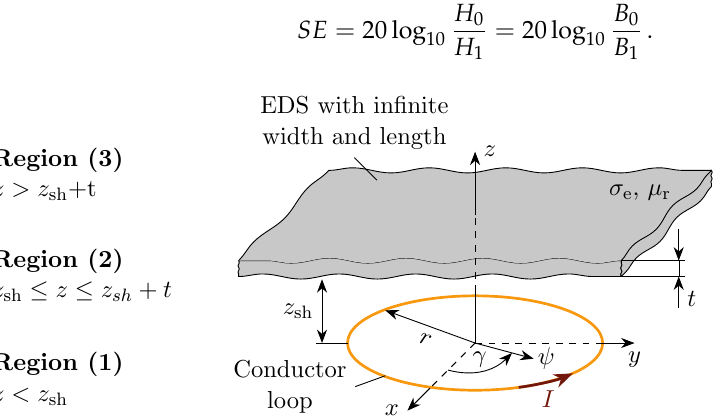
Figure 2. Model of a plane plate as EDS with infinite lateral dimensions and a parallel-oriented coil according to